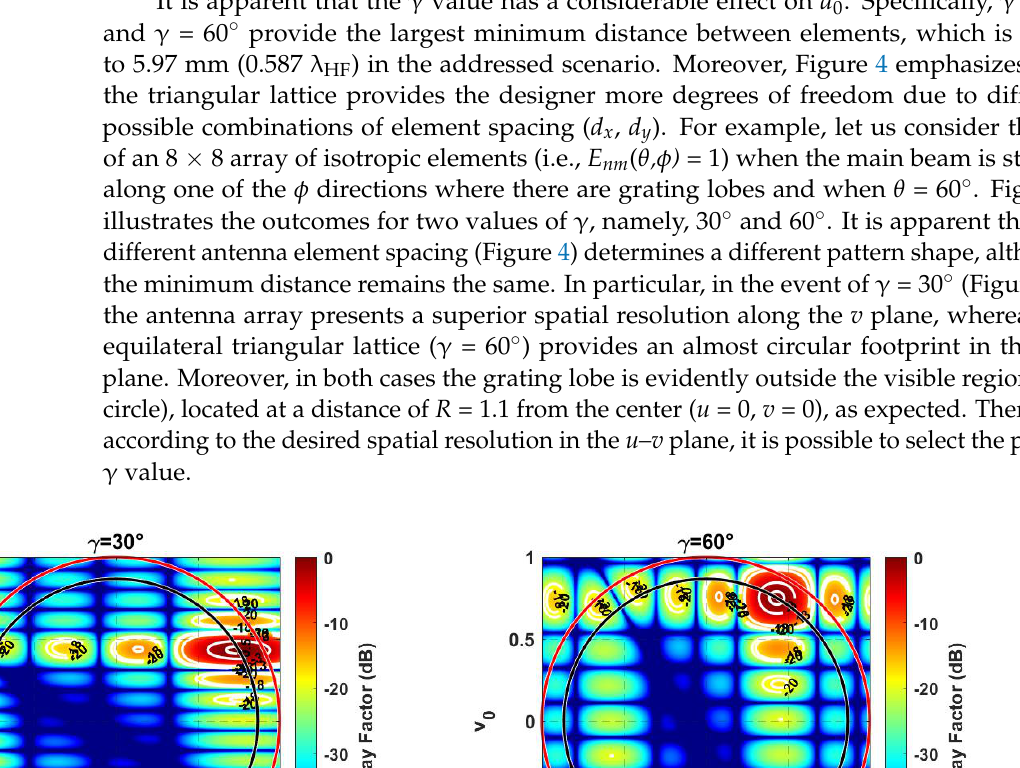
Figure 4. Elements’ spacing ( d x , d y ), the antenna elements’ distance ( D ), and its minimum ( d 0 ) as a function of the  value for a triangular lattice array in the event of R = 1.1.